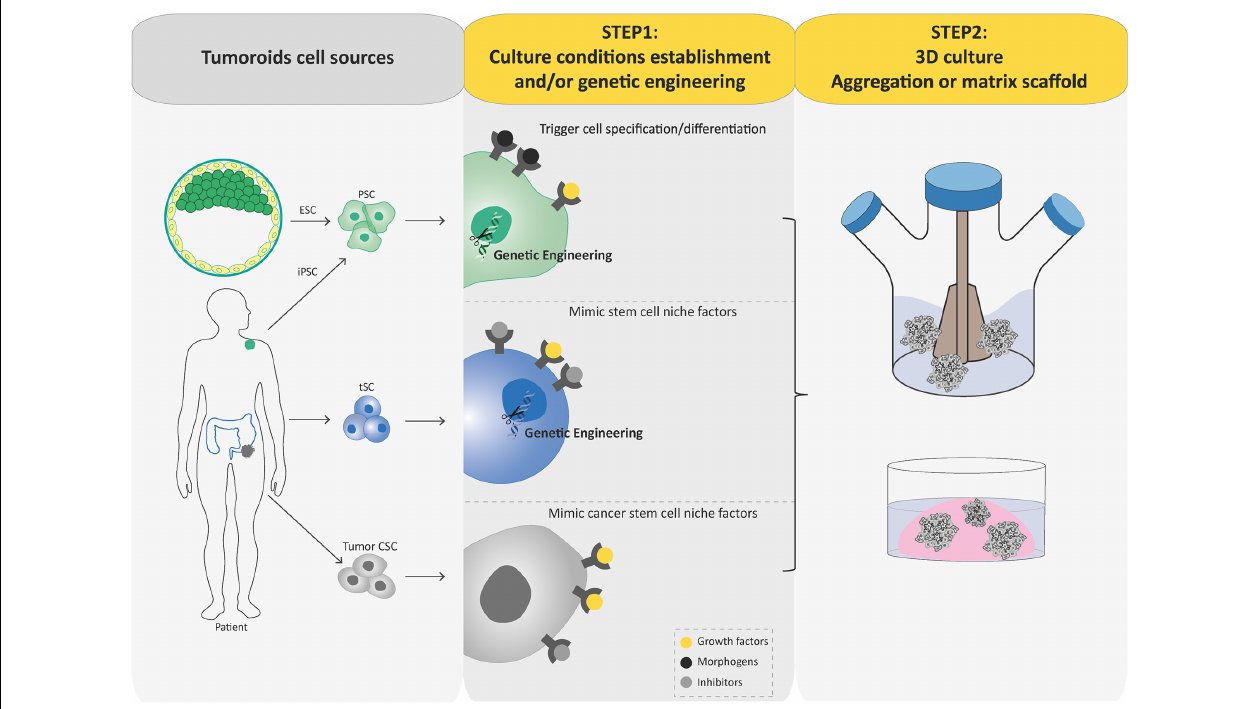
FIGURE 3 | Schematic diagram depicting current methods for generating tumoroids. Tumoroids can be established from PSCs (iPSC and ESC), tissue-specific SCs (tSCs), and directly from tumor biopsies, resection, or fluids (left-hand box). Similar to organoids, two key steps are involved in tumoroid derivation. Following genetic engineering (for PSCs and tSCs) and directed differentiation in a specific cell lineage by morphogens (for PSCs), identification of key cell signaling pathways to mimic CSC niche factors (growth factors and inhibitors) allows tumoral cells to be cultured in three dimensions (aggregation or matrix scaffold; central and right-hand